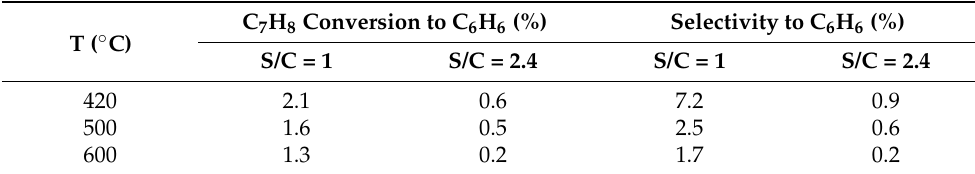
Table 2. The conversion of toluene to benzene and benzene selectivity during catalytic runs of SRT over Ni/CeZrO 2 at t c = 0.36 s, and S/C = 1 and 2.4, determined after 24 h time-on-stream at each